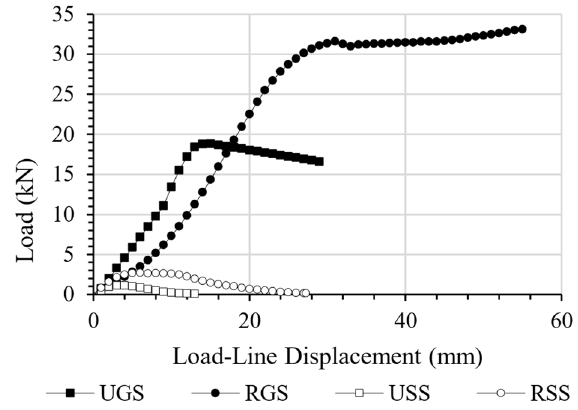
Figure 8. Load-line displacement diagram for all scenarios.